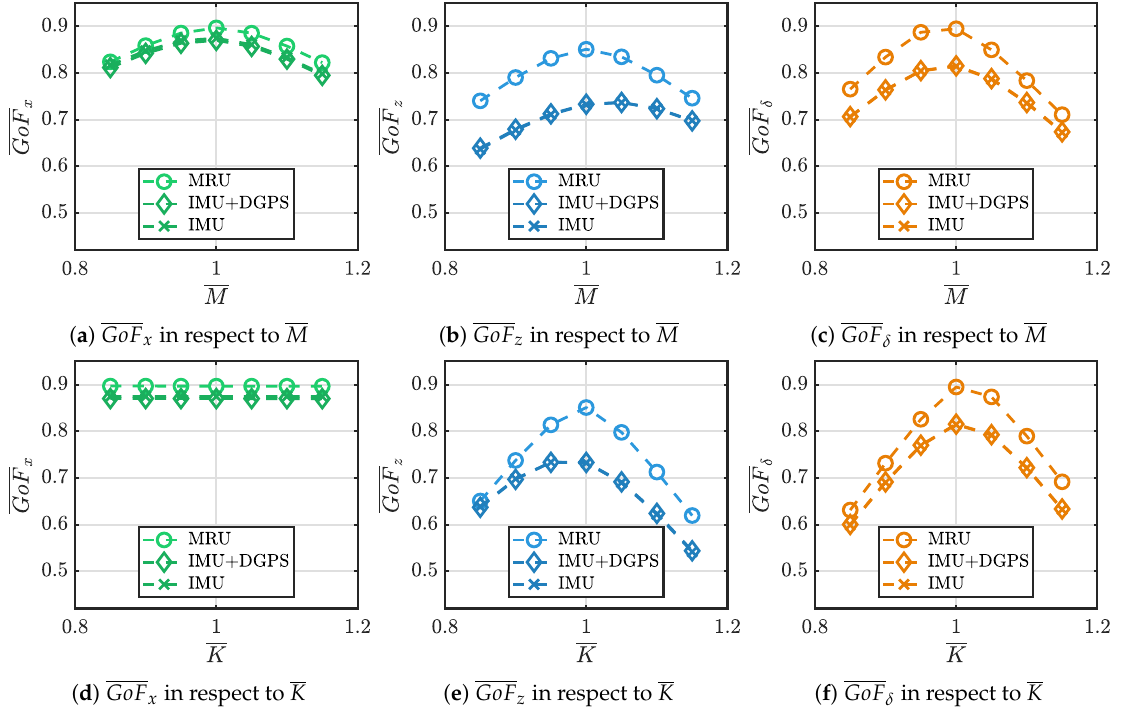
Figure 12. GoF results obtained with the KF varying M and K . The first column refers to the x DoF ( a , d ), the second to the z DoF ( b , e ) and the third to the δ DoF ( c , f